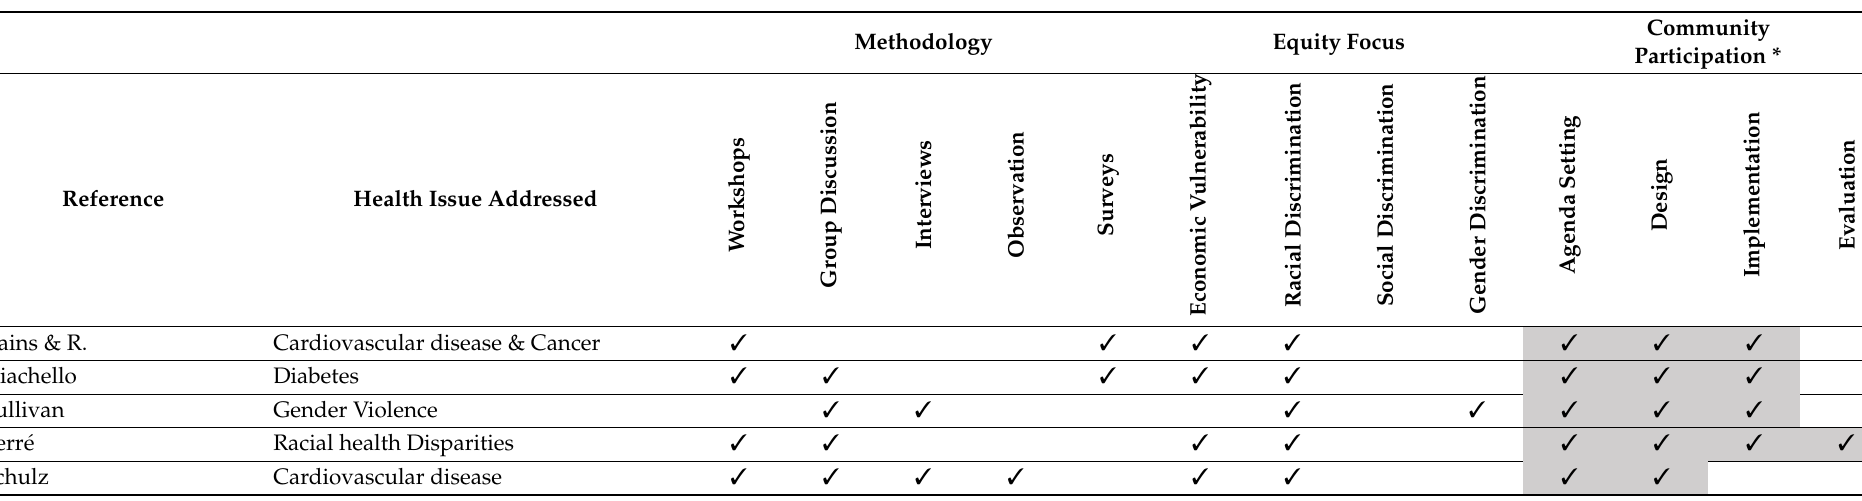
Table 2. Participatory methodology, equity focus, and community participation in 31 co-created public health actions